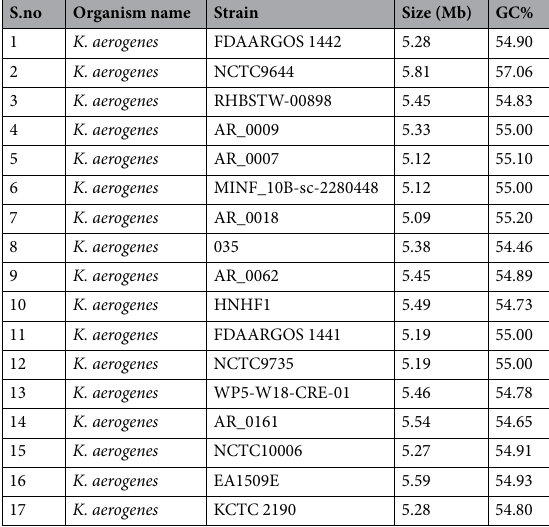
Table 1. Genomics statistics of K. aerogenes strains.